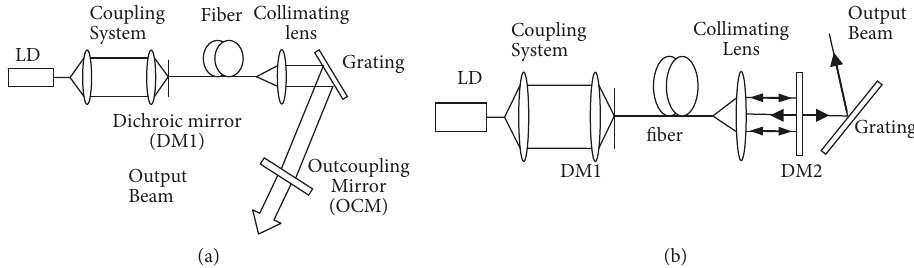
Figure 1: Schematic diagram of tunable fiber laser (a). Configuration 1 (b). Configuration 2.